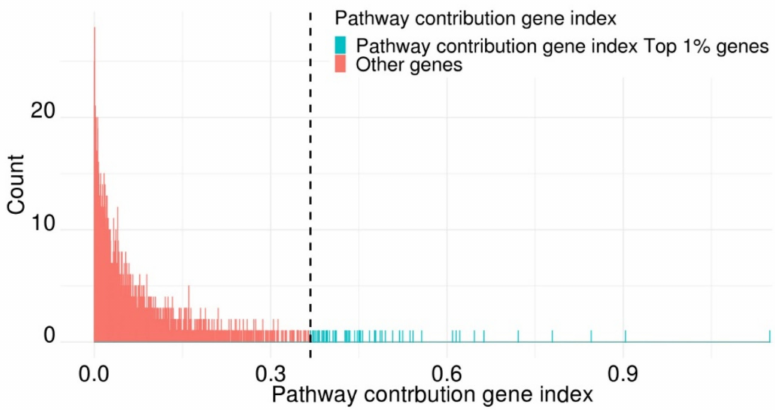
Figure 3. Pathway contribution gene index